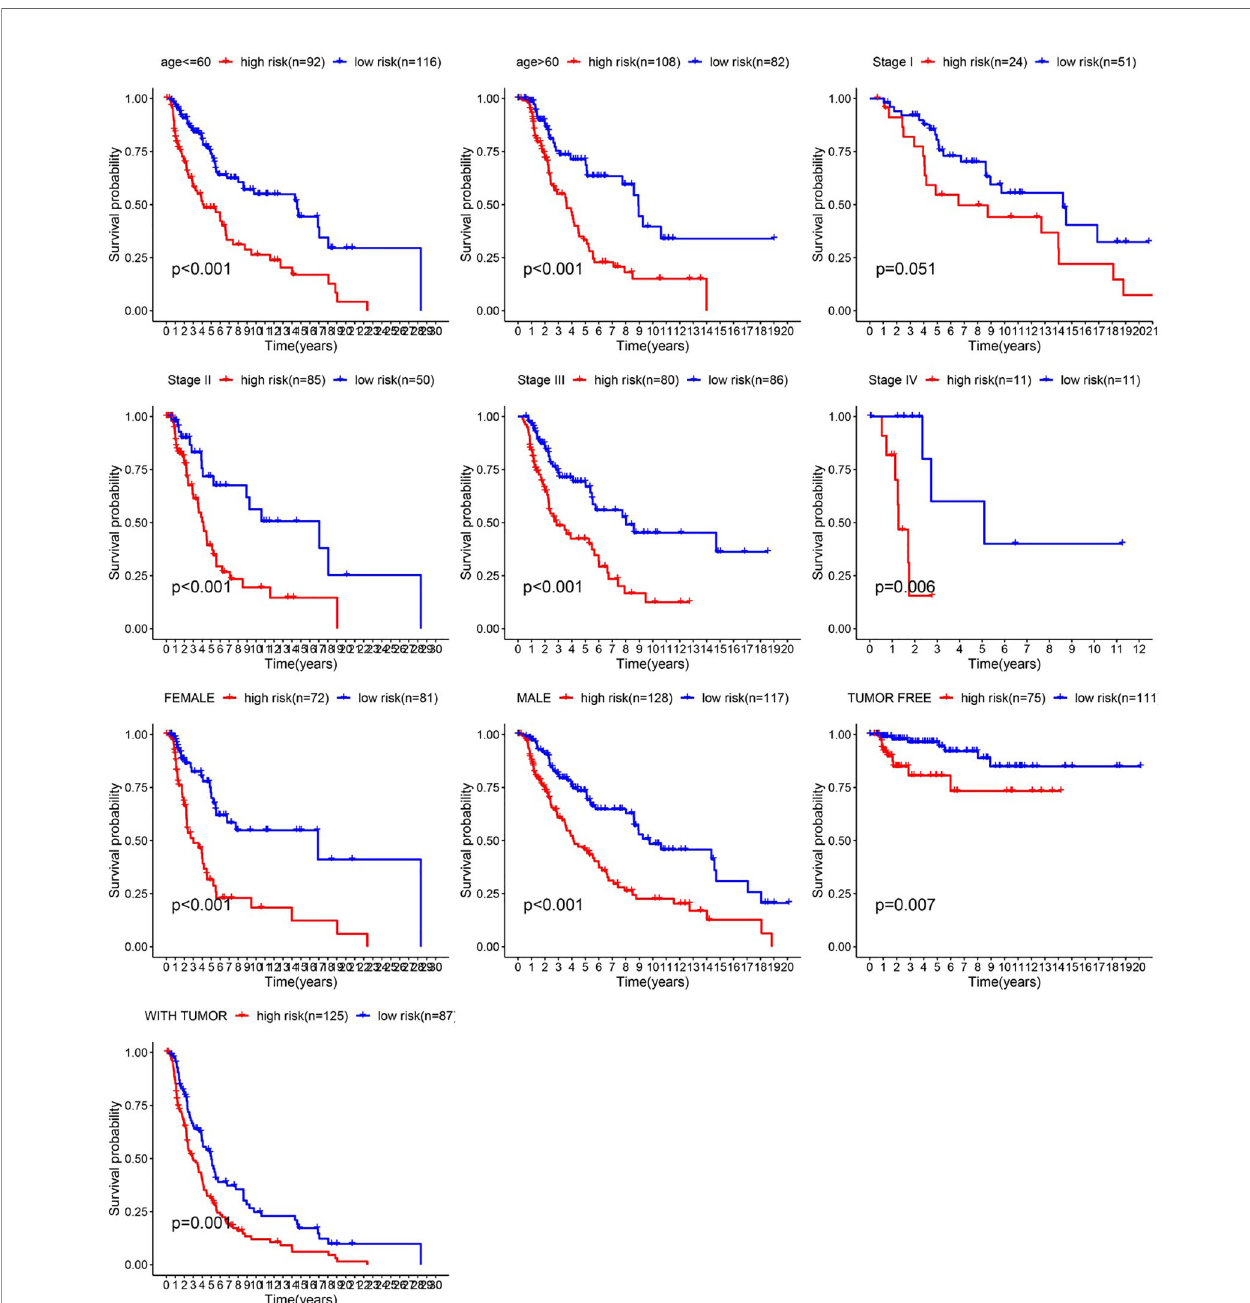
FIGURE 6 | Survival time of patients in high-risk and low-risk cluster of different